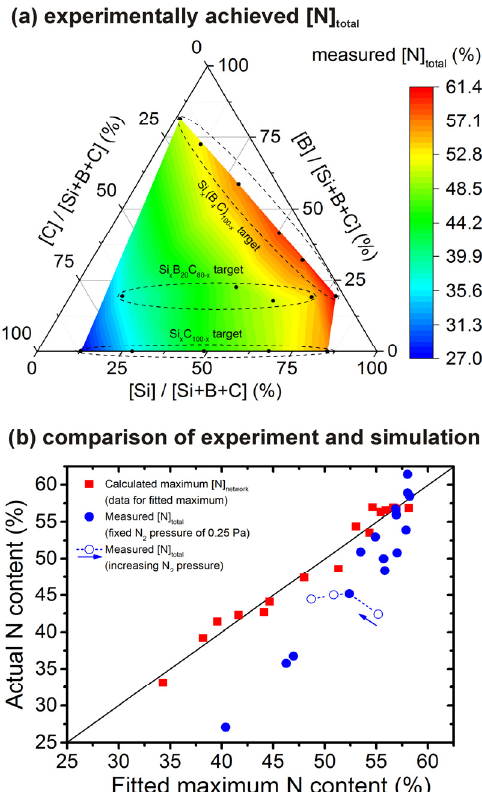
Figure 4. Panel ( a ) shows experimental values of [N] total in Si-B-C-N (neglecting the impurities) prepared by reactive magnetron sputtering in 0.250 Pa of N 2 + 0.250 Pa of Ar. The black balls correspond to compositions obtained using Si x C 100- x targets [46], Si x B 20 C 80- x targets [4] and Si x (B 4 C) 100- x targets [19] (bottom, middle and top dashed oval, respectively). Panel ( b ) compares these experimental values with those given by Equation (3). The squares are calculated maxima of [N] network (Figure 2b). The diagonal line represents Equation (3) (fitted using these calculated data). The balls are the aforementioned values of [N] total in Si-B-C-N (neglecting the impurities) obtained by reactive magnetron sputtering in 0.250 Pa of N 2 + 0.250 Pa of Ar using Si x C 100- x , Si x B 20 C 80- x and Si x (B 4 C) 100- x targets (full balls [4,19,46]) or in 0.125–0.500 Pa of N 2 at a fixed total pressure of 0.500 Pa using the Si 40 C 60 target (empty balls [53]; this dependence is not vertical because of different ratios of sputtering yields of individual elements by N 2+ and by Ar + ).